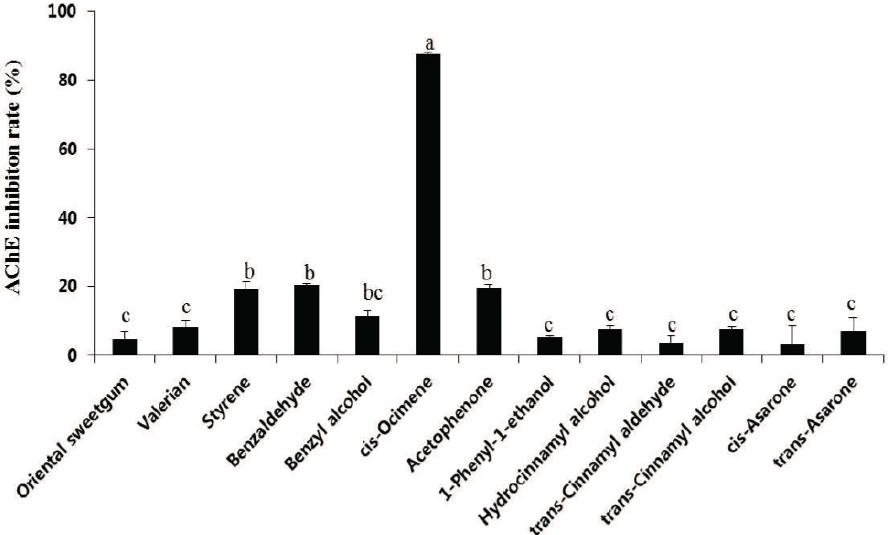
Figure 2. Japanese termite acetylcholinesterase inhibition rates of oriental sweetgum, valerian oil and their constituents at 1 mg/mL. Mean values corresponding to each treatment with different letters are significantly different from one another (F p < 0.0001, Scheffé’s